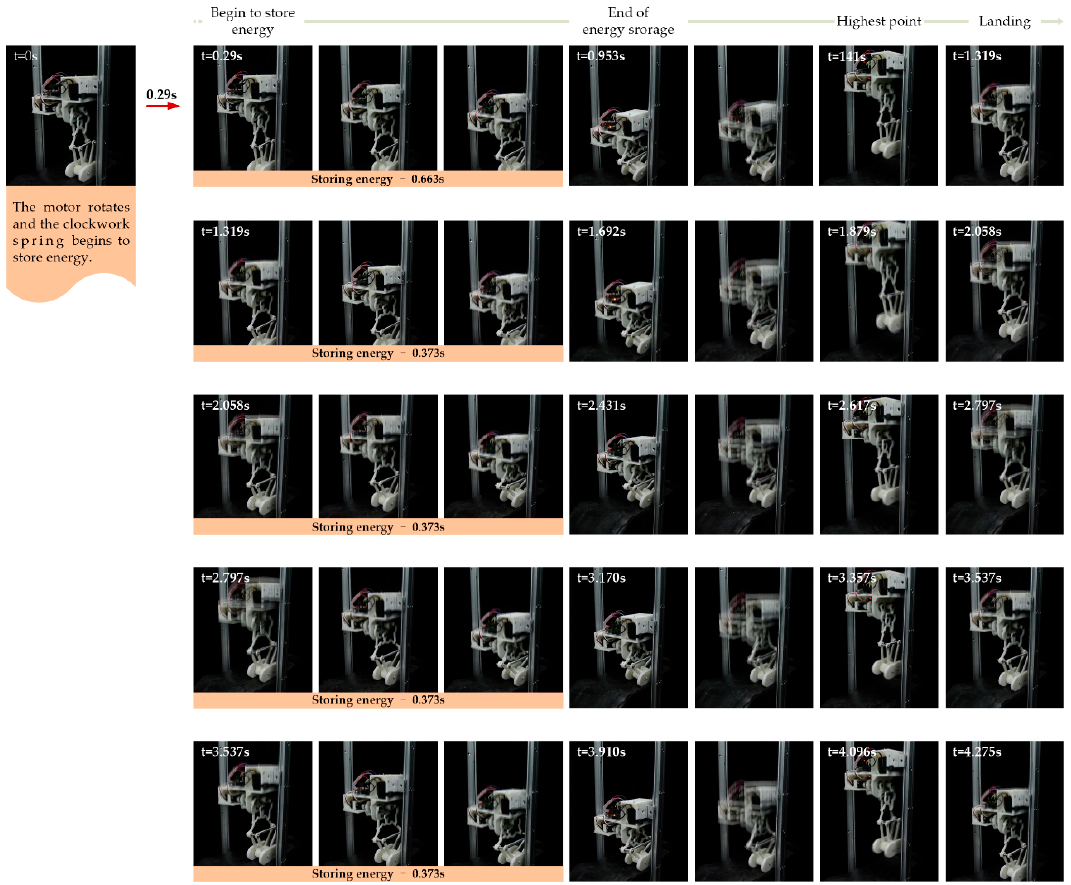
Figure 16. Experimental process of hopping performance test.